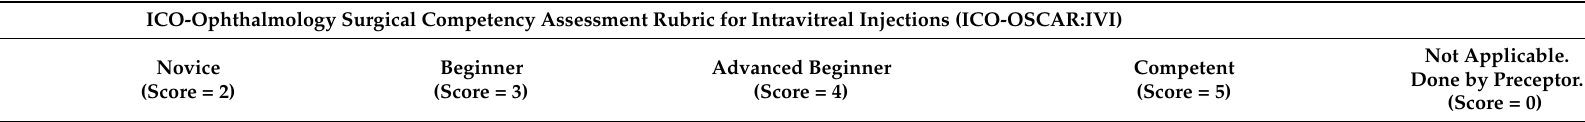
Table A1. ICO-Ophthalmology Surgical Competency Assessment Rubric for Intravitreal Injections (ICO-OSCAR: